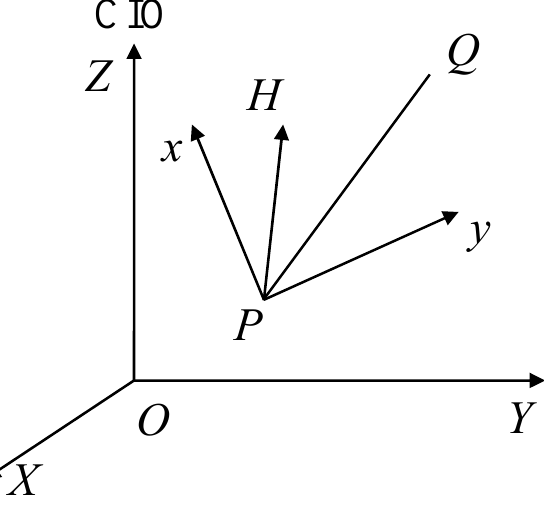
Figure 5. The left-hand coordinate system.